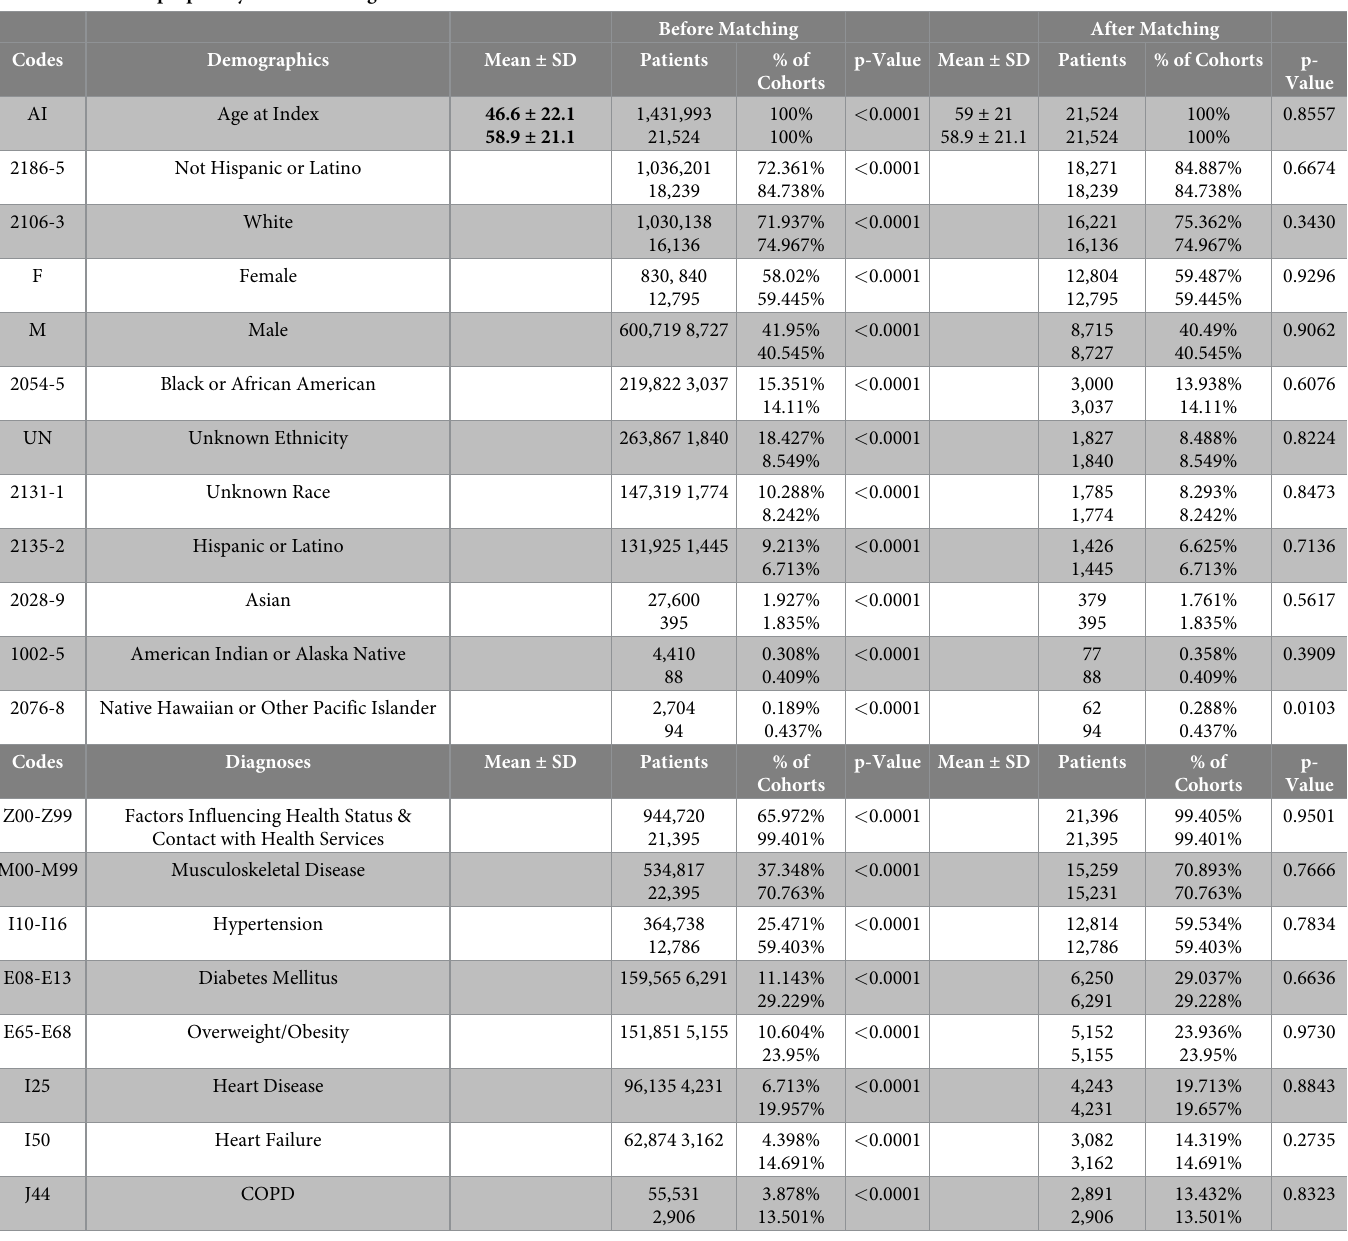
Table 2. Results of propensity score matching to balance